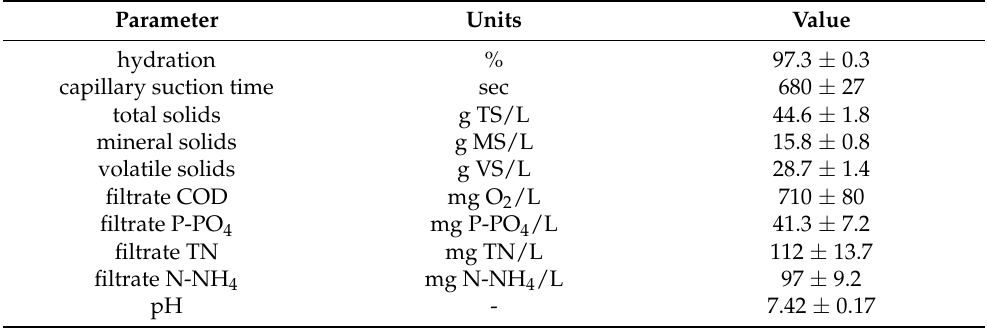
Table 2. Characteristics of anaerobic granular sludge used as inoculum in the study ( ± std. dev., n = 16). Parameter